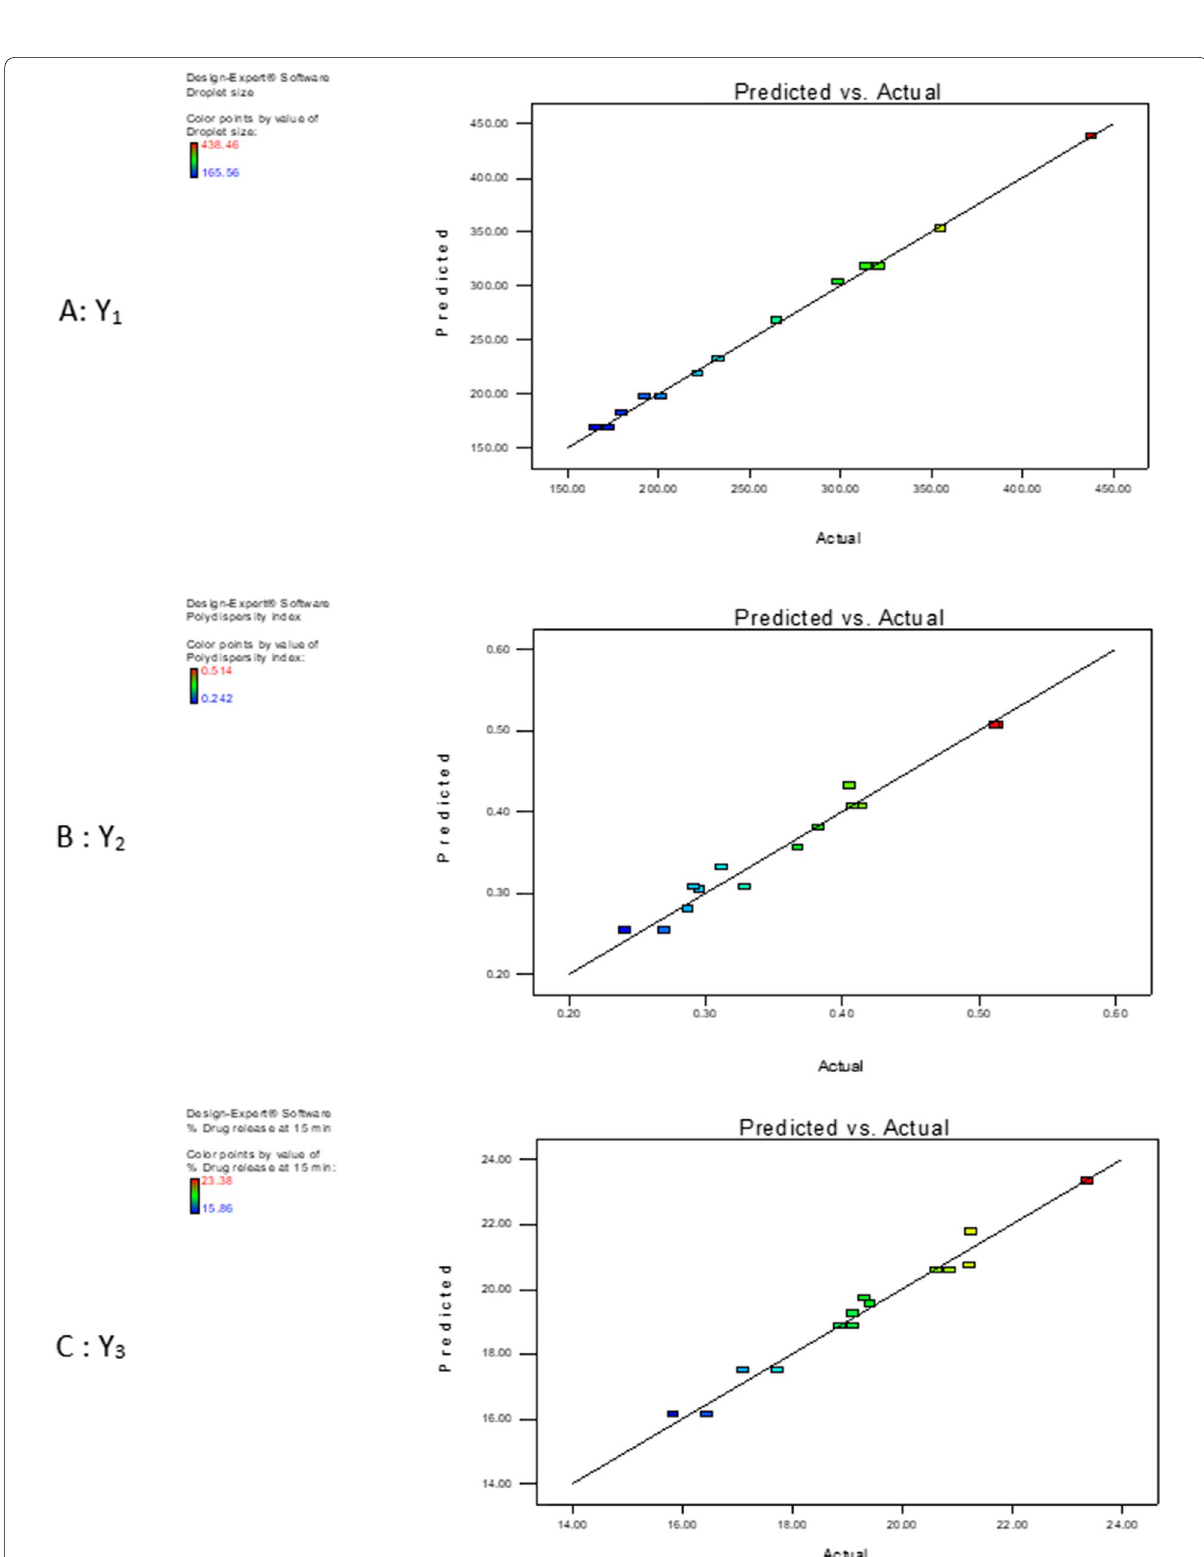
Fig. 6 2D plots illustrating the obtained versus predicted values for the responses A droplet size B polydispersity index C percent drug release at 15